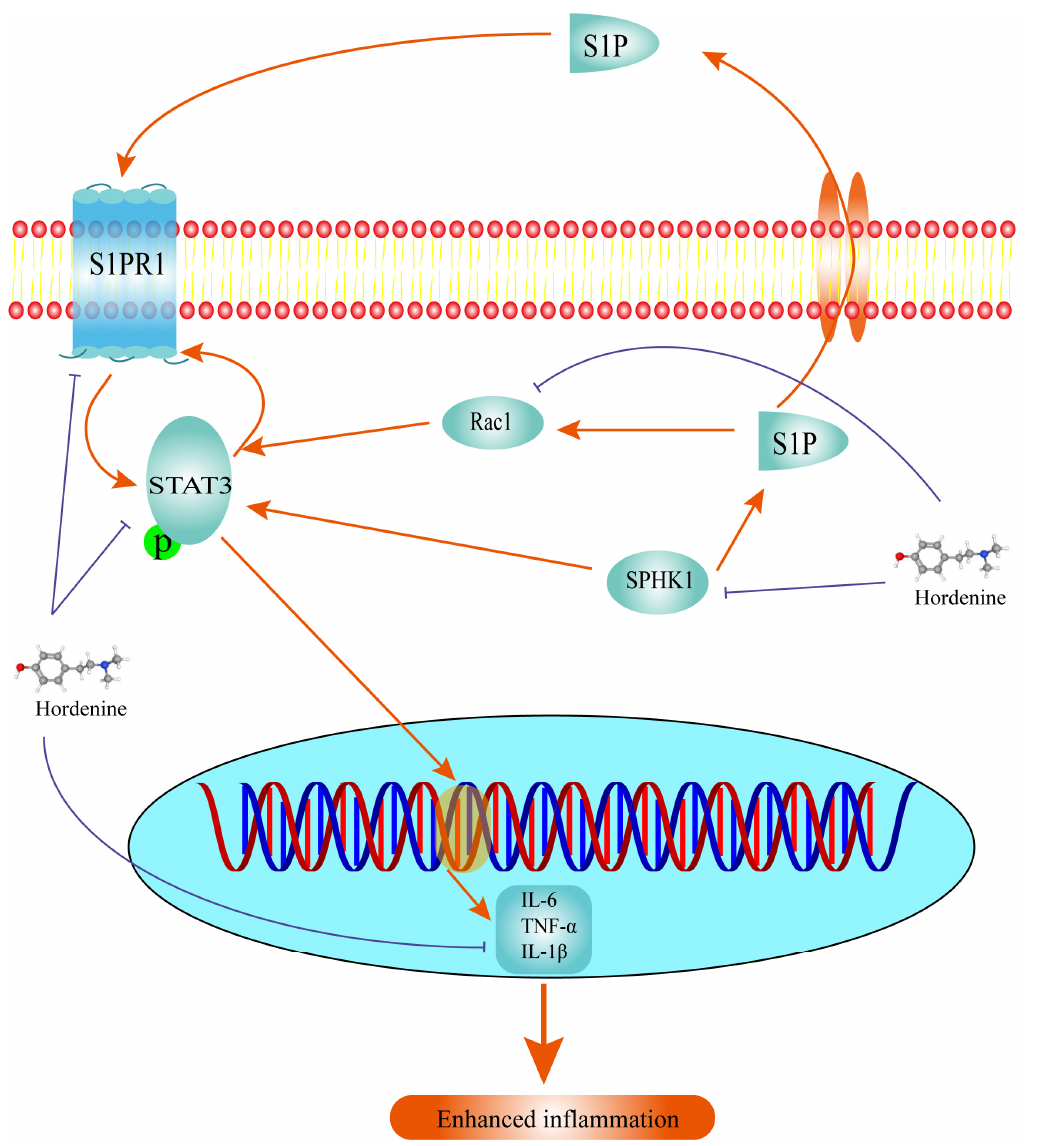
Figure 5. Sphingosine kinase 1 (SPHK1)/sphingosine-1-phosphate receptor 1 (S1PR1)/signal trans- ducer and activator of transcription 3 (STAT3) signaling pathway and the role of ras-related C3 botulinum toxin substrate 1 (Rac1) in hordenine’s inhibition of dextran sodium sulfate-induced ulcerative